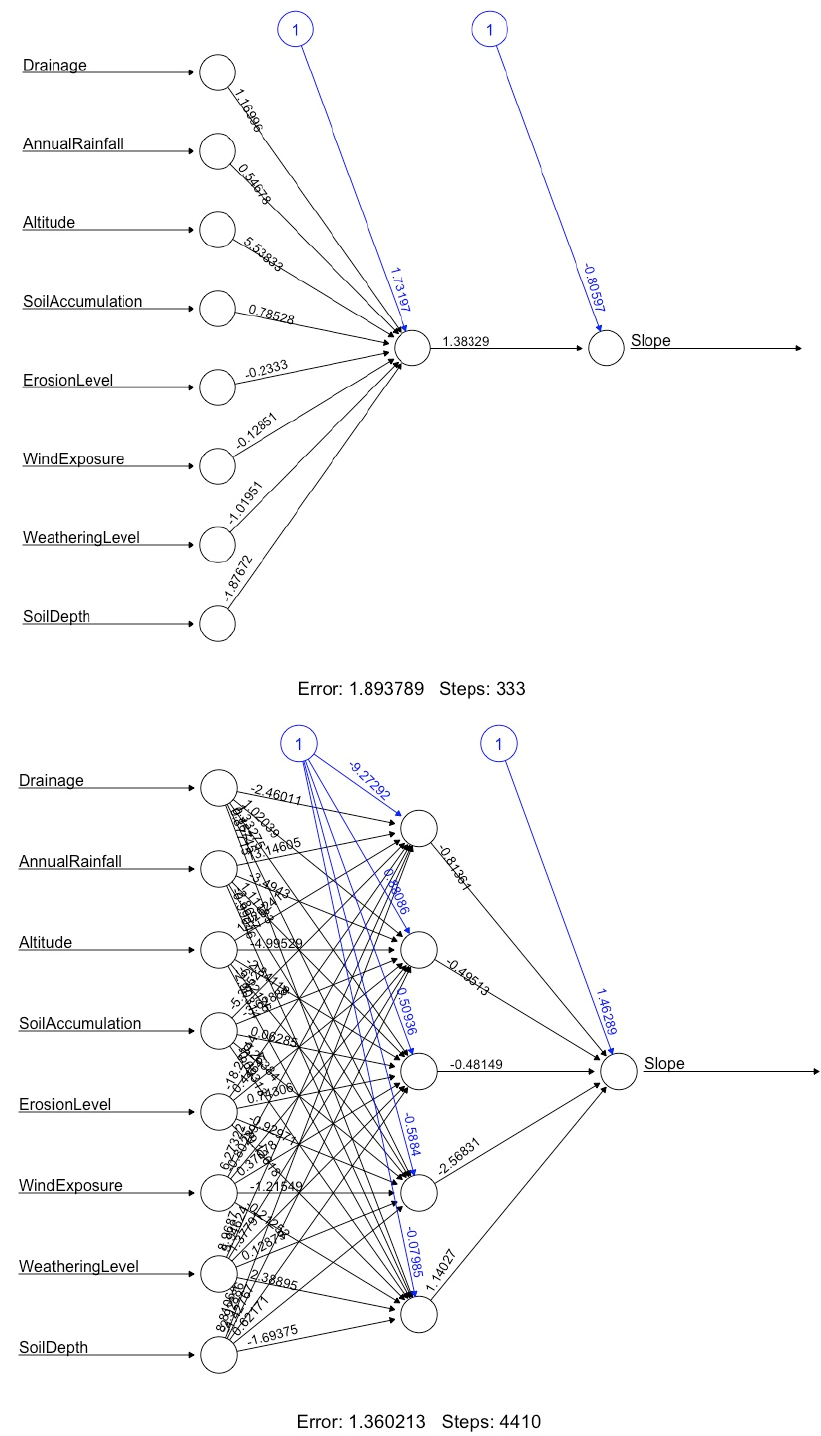
Figure 5. Multi − layer forward network with a single and five hidden nodes to Slope. Figure 5. Multi–layer forward network with a single and five hidden nodes to The multi-layer forward network with a single node to Slope (Upper, Figure 5) indi- cates that Altitude is the strongest element affecting Paulownia coreana habitats with Slope (5.53). Other environmental variables such as Soil Depth ( − 1.87), Drainage (1.16), Weath- ering Level ( − 1.01), Soil Accumulation (0.78), Annual Rainfall (0.54), Erosion Level ( − 0.23), and Wind Exposure ( − 0.12) follow in descending order of their effects (Table 1). In our comparison of a single node and five hidden nodes, while the number of train- ing steps increased from 333 to 4410, the reported error decreased from 1.89 to 1.36. Simi- lar to the altitude analysis, this result explains that more complicated models provide bet- ter performance outcomes owing to the optional weights added to complicated models. Based on the cross-analysis of environmental variables between Altitude and Slope, we thus conclude that Altitude and Slope are the main attributes affecting the habitat suit- ability modeling of Paulownia coreana . While the environmental variables were assessed in conjunction with ANN algo- rithms, Decision Tree algorithms were implemented to create HSMs. For the Decision Tree modeling, additional tree species were introduced in order to carry out comparisons of habitat suitability. Moreover, as well as the ANN process, the Decision Tree models with the additional species enables us to identify the environmental variables which signifi- cantly affect the habitat suitability. Therefore, additional tree species of Robinia pseudoaca- cia , Quercus variabilis , and Pinus densiflora were selected. Decision Tree algorithms are com- monly implemented in the ecology field since they produce accurate and statistical out- comes. The HSMs for individual tree species will be created based on environmental var- iables; when all available information surveyed is included, more accurate HSMs for par- ticular species habitats can be created. This study developed a simple HSM especially im- plementing C5.0 DT packages. The dataset used includes 2497 examples on nine topographic and climatic environ- mental variables (Table 1) previously identified from four species ( Paulownia coreana , Ro- binia pseudoacacia , Quercus variabilis , Pinus densiflora ). A class variable indicates which spe- cies are which out of the four species. The ANN process R 1.74 was employed for the Decision Tree procedure.